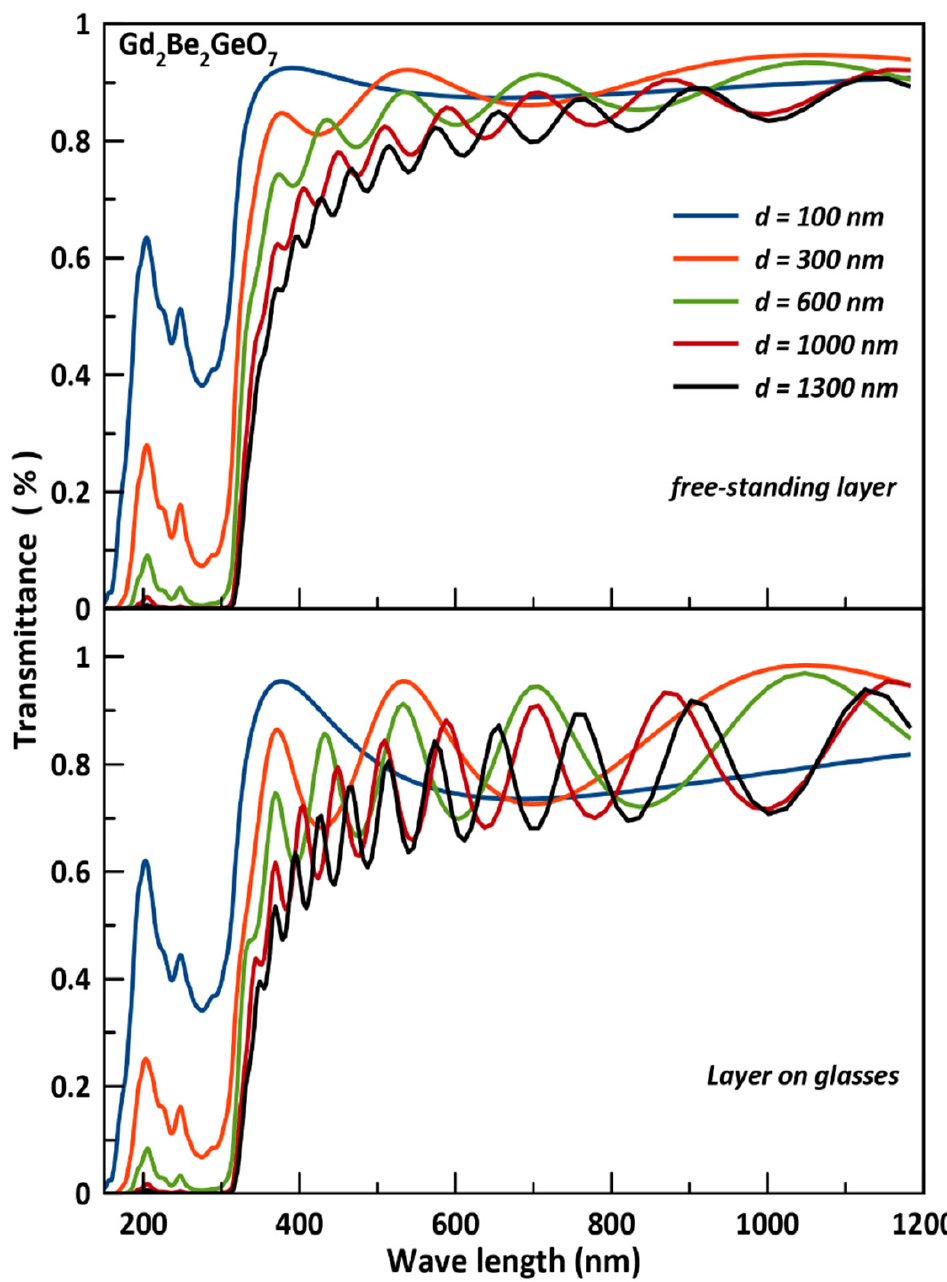
Figure 10. The transmittance spectra for Gd 2 Be 2 GeO 7 thin films employing varying thicknesses in both processes of coating (free-standing layer and layer mounted on glasses).